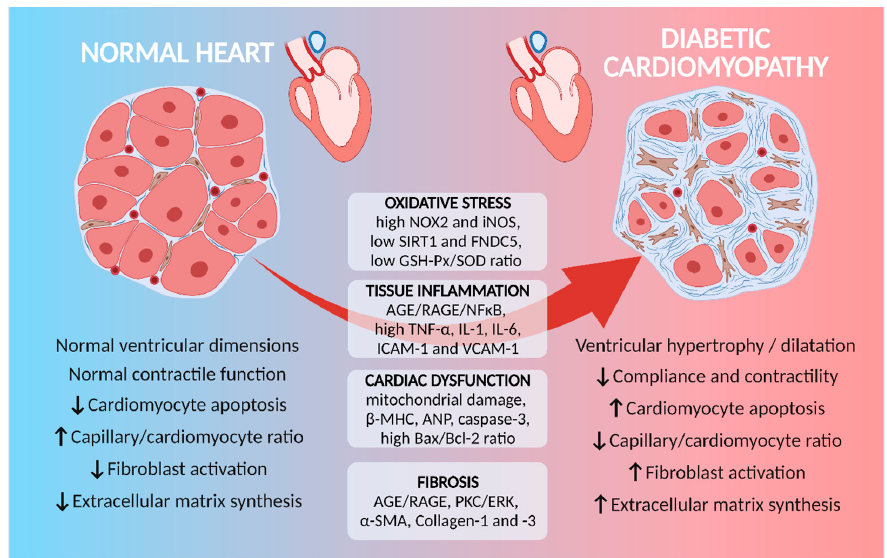
Figure 1. Cardiac functional and morphological alterations in diabetic cardiomyopathy (DCM).